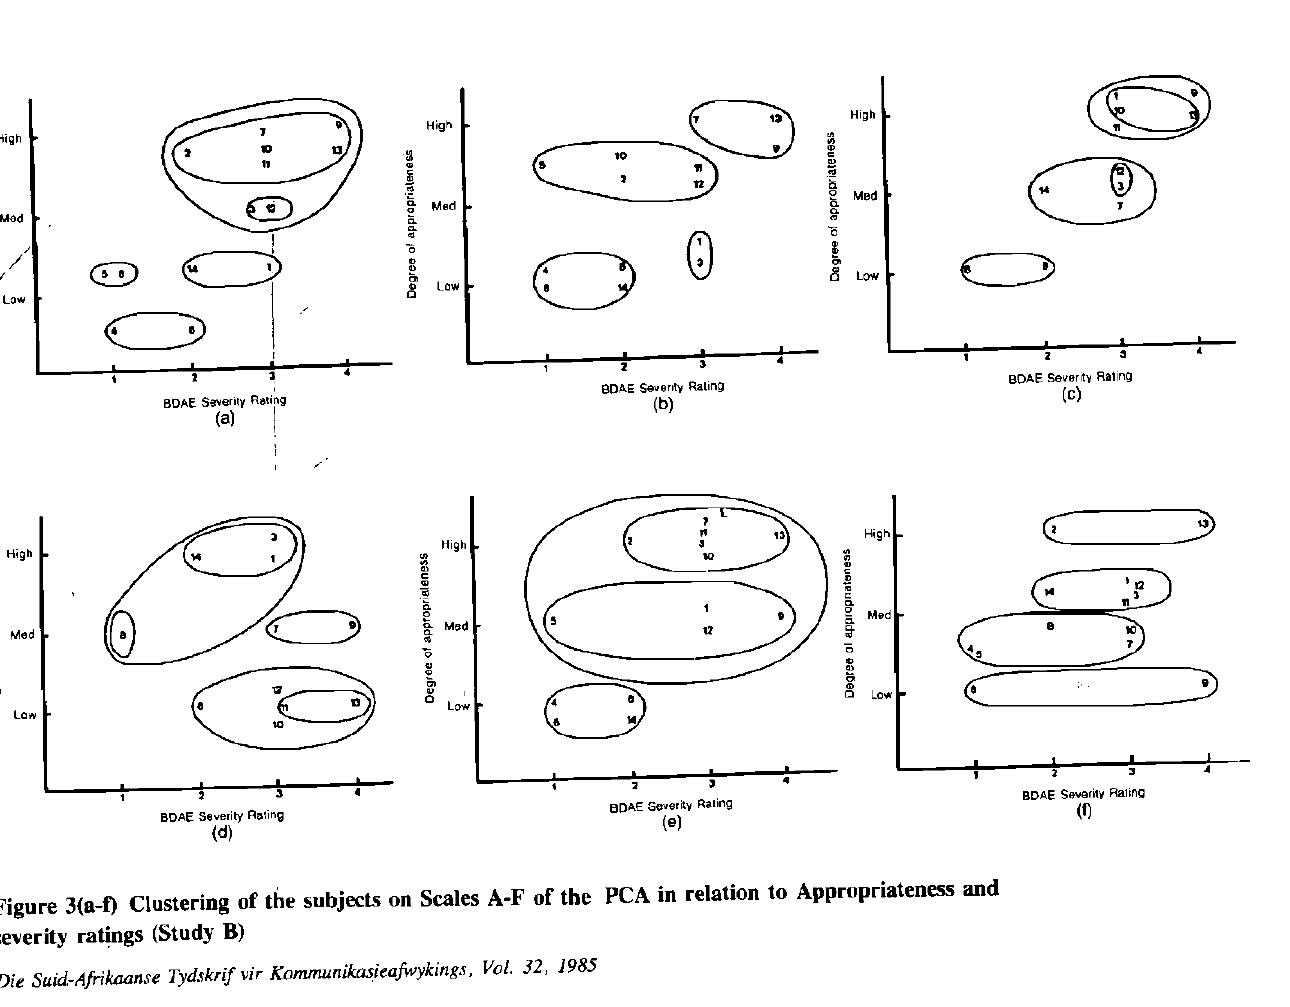
Figure 3(a-f) Clustering of the subjects on Scales A-F of the PCA in relation to Appropriateness and severity ratings (Study